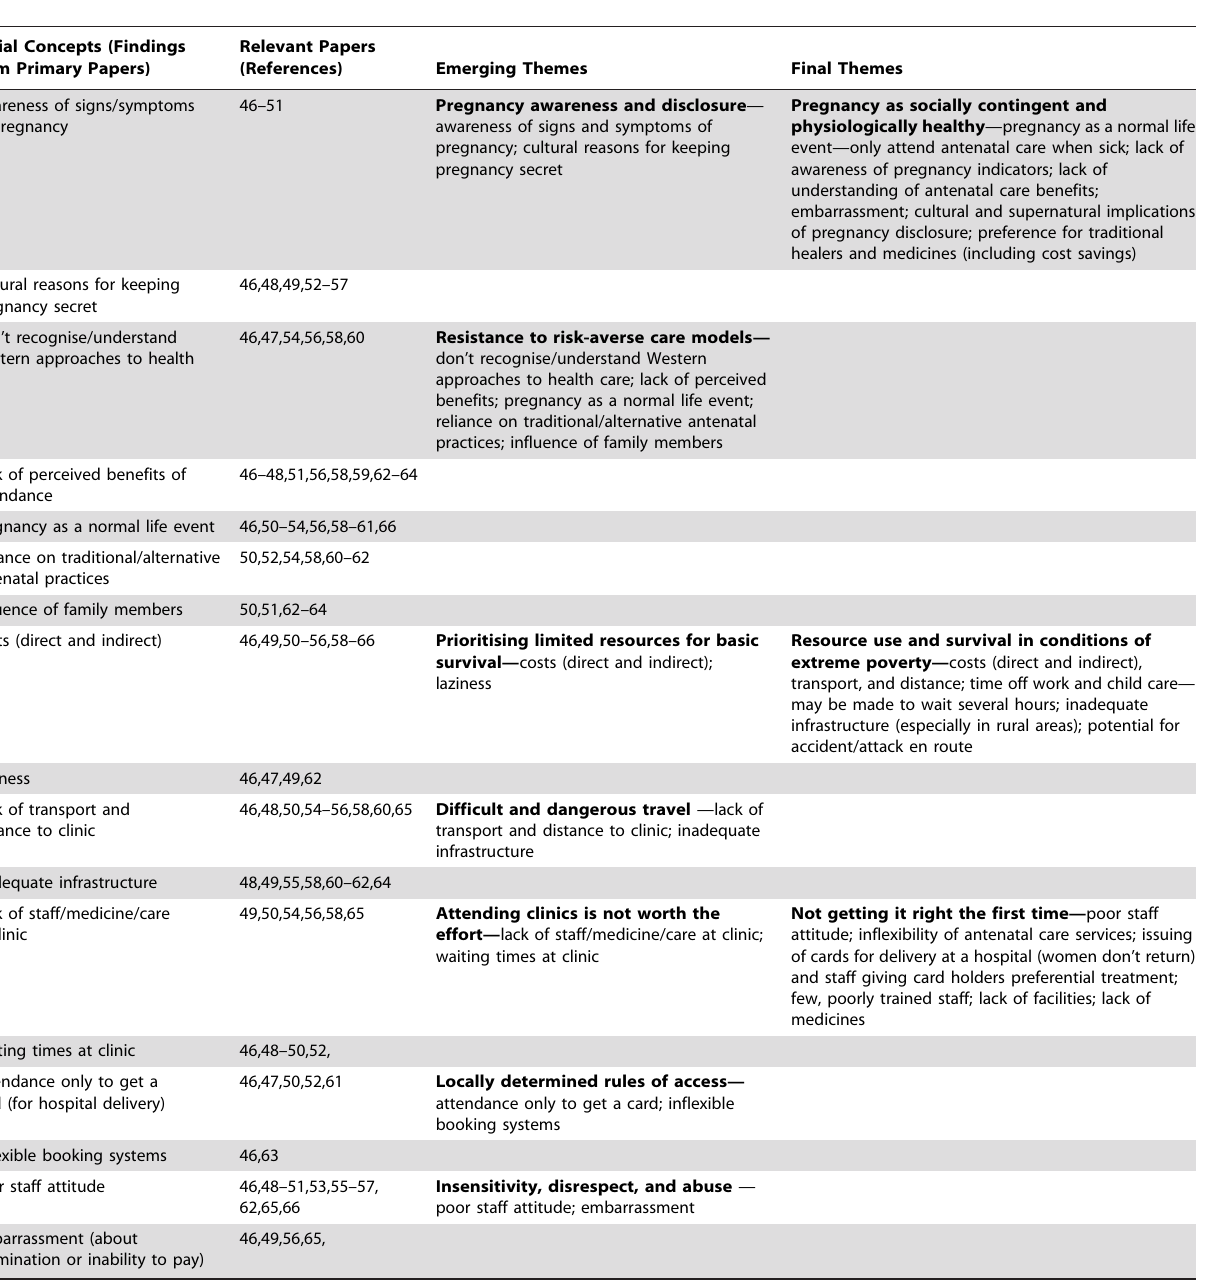
Table 2. Summary of